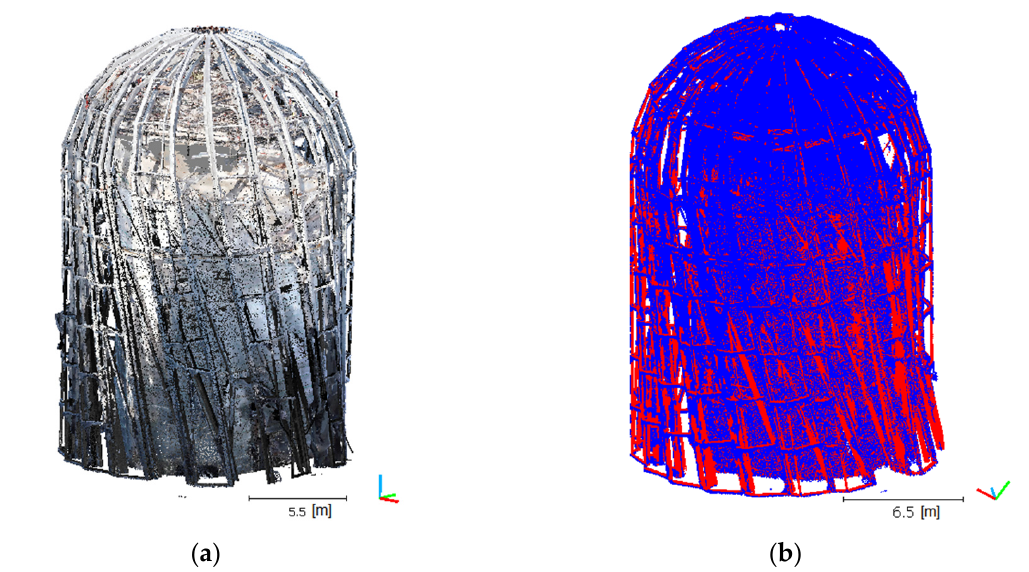
Figure 9. Integrated point clouds using two sources. ( a ) Visualization of the RGB palette points for the UAV cloud and the grayscale for reflection intensity for the UAV and TLS cloud; ( b ) blue — UAV cloud, red — TLS cloud.